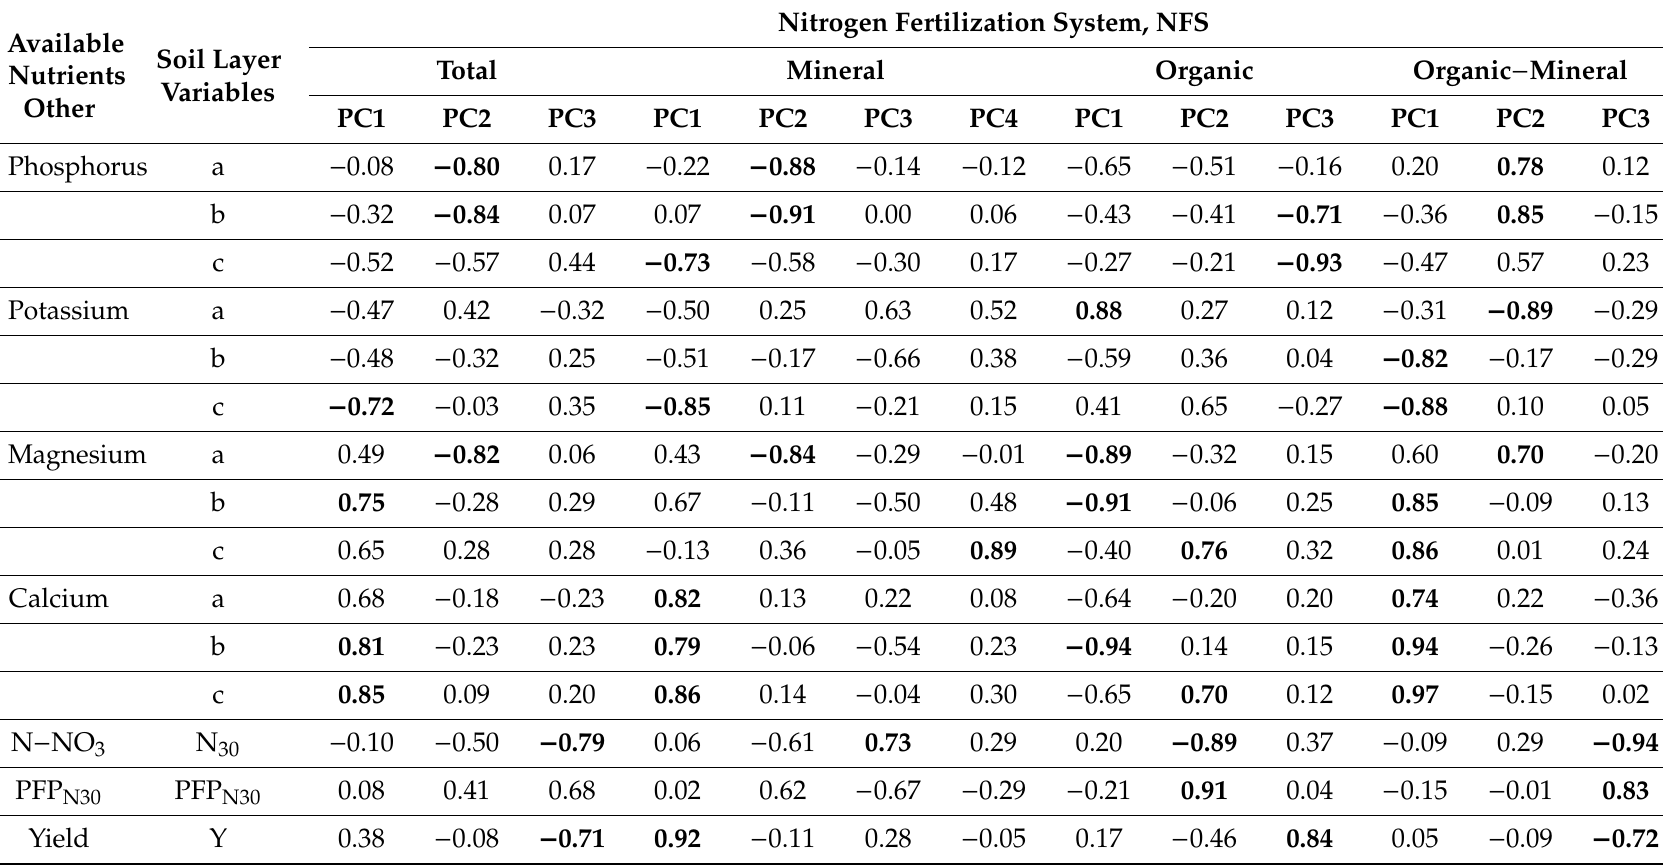
Table A2. Principal component analysis of the content of available nutrients and nitrate nitrogen, and yield at the onset of WOSR stem elongation (BBCH